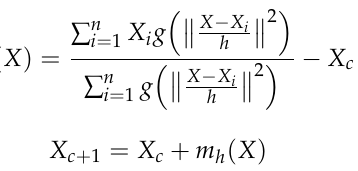
11 of 25 Figure 7. iForest to determine the outlier : characteristics of abnormal points: few and different. In the iForest algorithm, the contamination value is an important hyperparameter that represents the approximate proportion of outliers in the dataset. However, most of the current contamination values need to be specified by continuous commissioning and are not highly automated. For this problem , this paper designs a method to automatically calculate the pollution value by using the centroid data obtained after processing by BIRCH clustering algorithm. First of all, we calculate the point with the highest neighbor density among all cen-